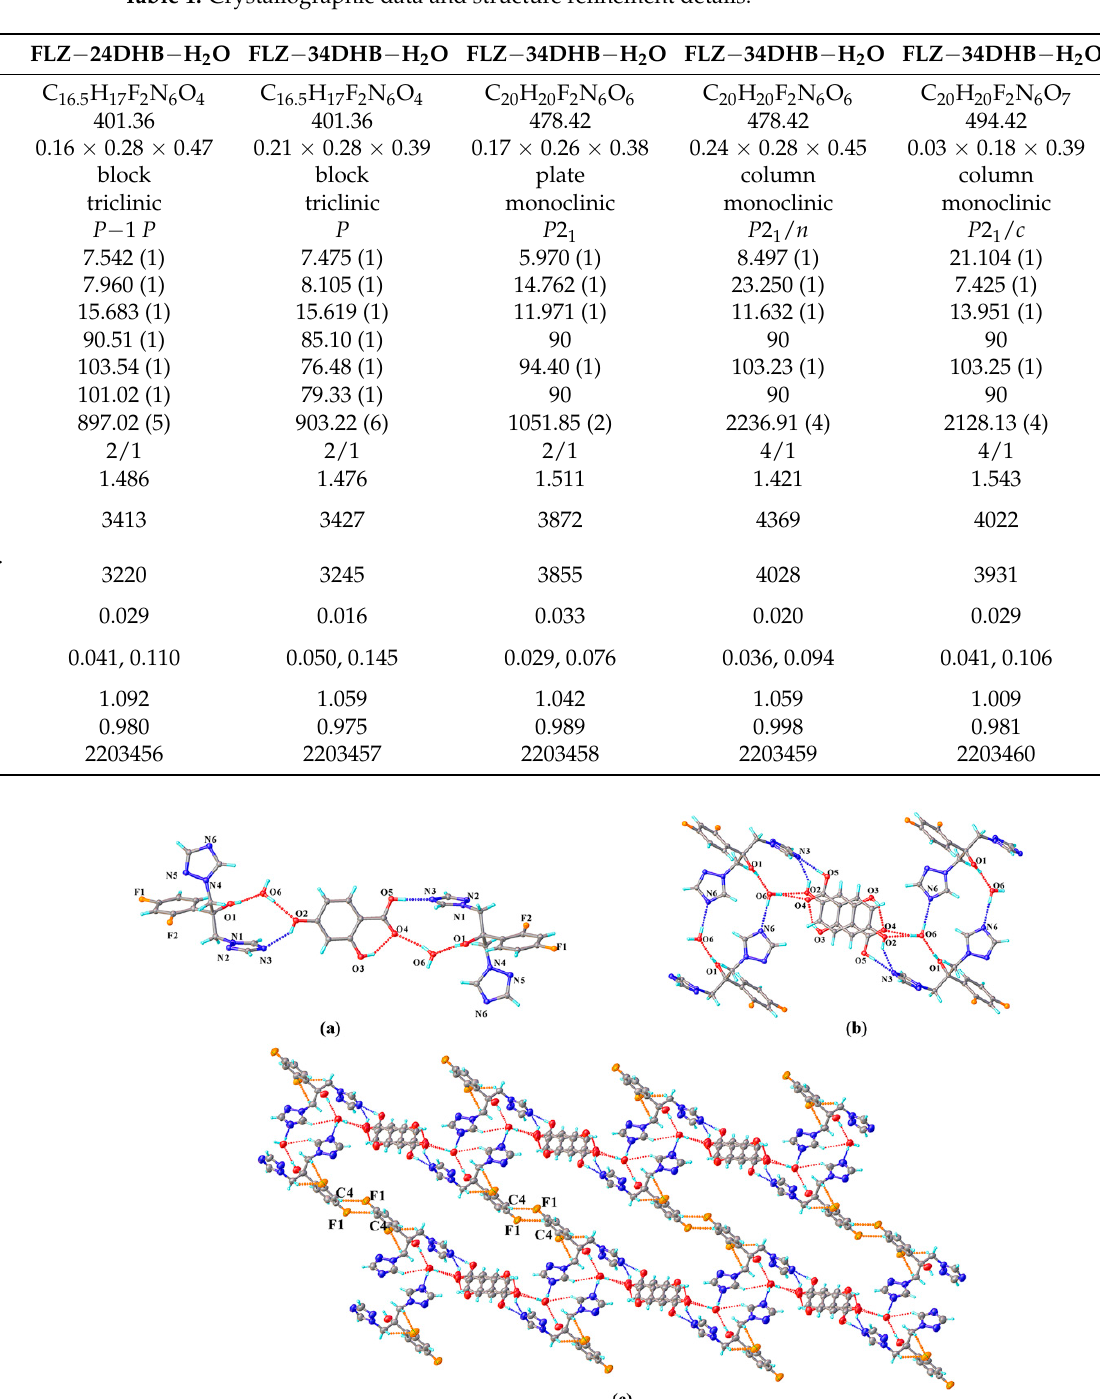
Table 1. Crystallographic data and structure refinement details.